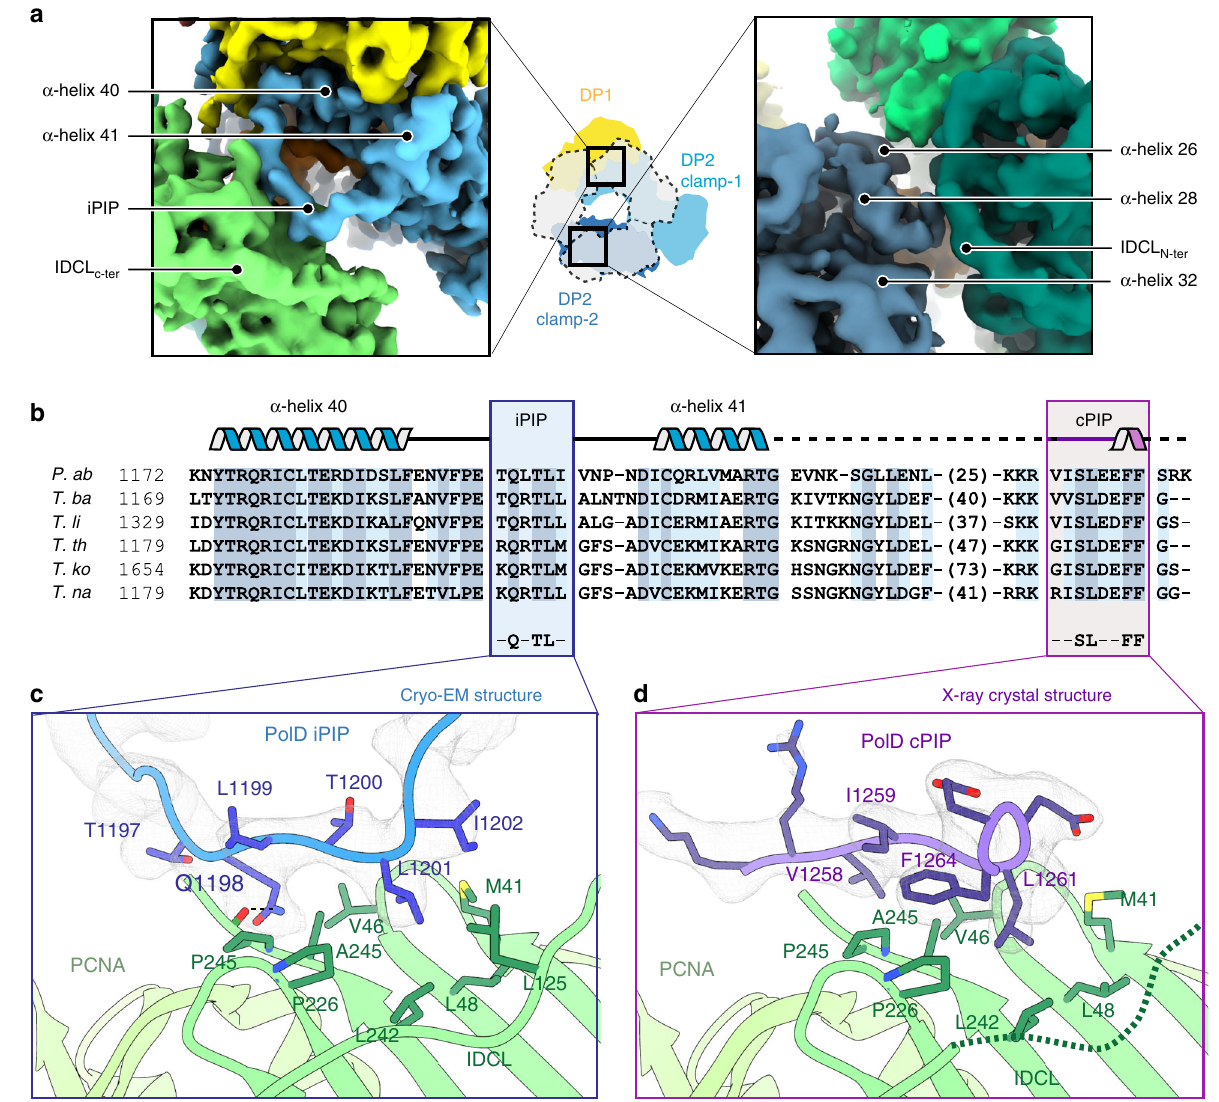
Fig. 3 PolD uses two distinct PIP-boxes for molecular recognition of PCNA. a Two views of the cryo-EM map showing the interfacial region between the DP2 clamp-1 (left) and clamp-2 (right) binding to PCNA. DP2 clamp-1 and clamp-2 domains are represented in light and dark blue, respectively; DP1 is shown in yellow; DNA in orange; PCNA in green. b Multiple-sequence alignment of the C-terminal region in Thermococcus species: P. abyssi (P.ab), Thermococcus barophilus (T.ba), Thermococcus litoralis (T.li), Thermococcus thioreducens (T.re), Thermococcus kodakarencis (T.ko), and Thermococcus nautili (T. na). Internal (iPIP) and C-terminal (cPIP) PIP-boxes are framed in blue and purple, respectively, with secondary structure elements shown above. Sequence similarities are highlighted with light blue boxes and conserved residues are highlighted with dark blue boxes. c Detailed view of the iPIP – PCNA interaction in the cryo-EM map contoured at a level of 7 σ . d Detailed view of the cPIP – PCNA interaction in the 2Fo-Fc X-ray electron density map contoured at a level of 1.5 σ